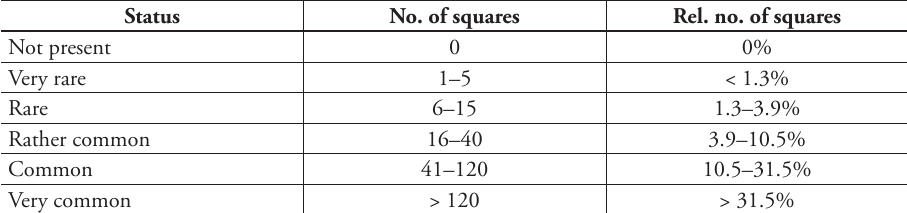
Table 3. Status categories for the Belgian woodlice, together with the lower and upper limits for the percent- age of squares where a species was recorded between March 2014 and December 2017 in a certain